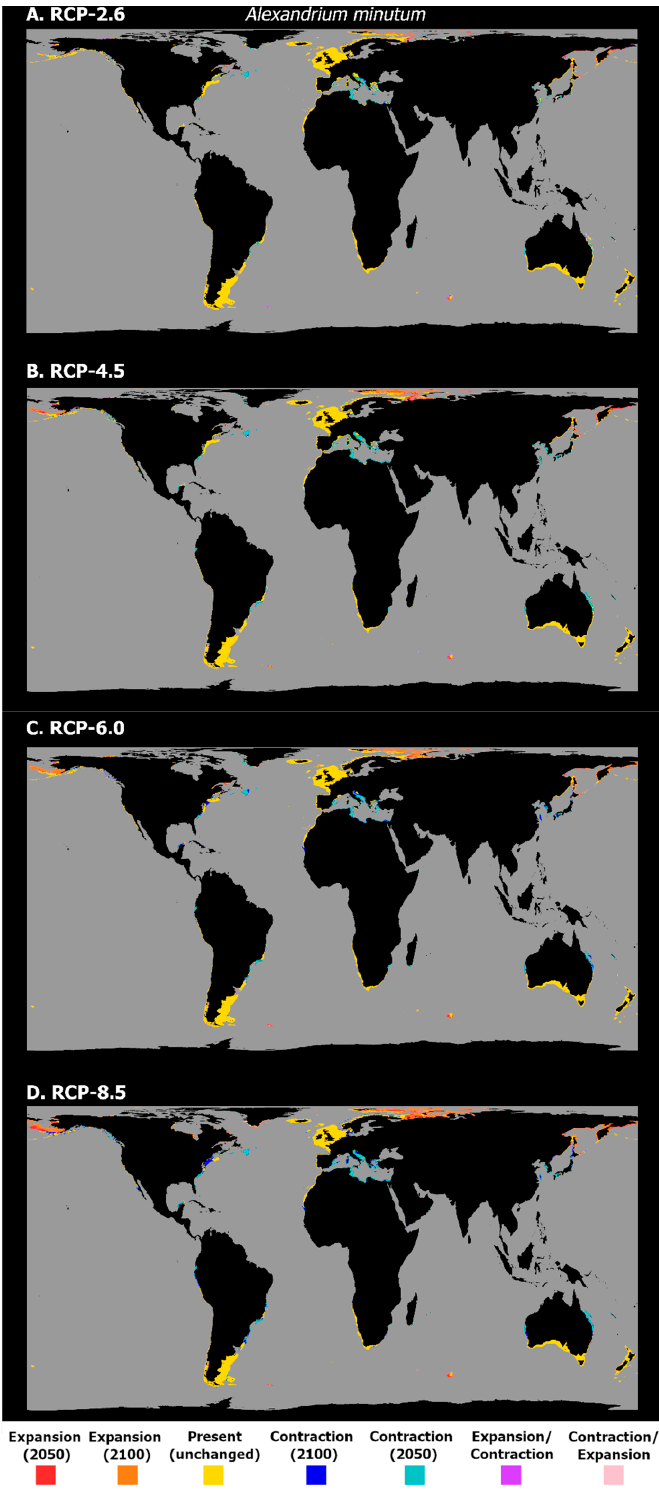
Figure 5. Projected distribution time maps for A. minutum , showing predicted unidirectional range shifts in occurrence distribution [i.e., range expansion (in red and orange) or contraction (in dark and light blue)] as well as transitory fluctuations (i.e., range contraction followed by expansion (pink), and vice-versa (purple)), for each Representative Concentration Pathway scenario (RCP-2.6, 4.5, 6.0, 8.5; CMIP5). A larger, higher-quality version of this figure is present in the Supplementary Material (See “High_Res_Figures”